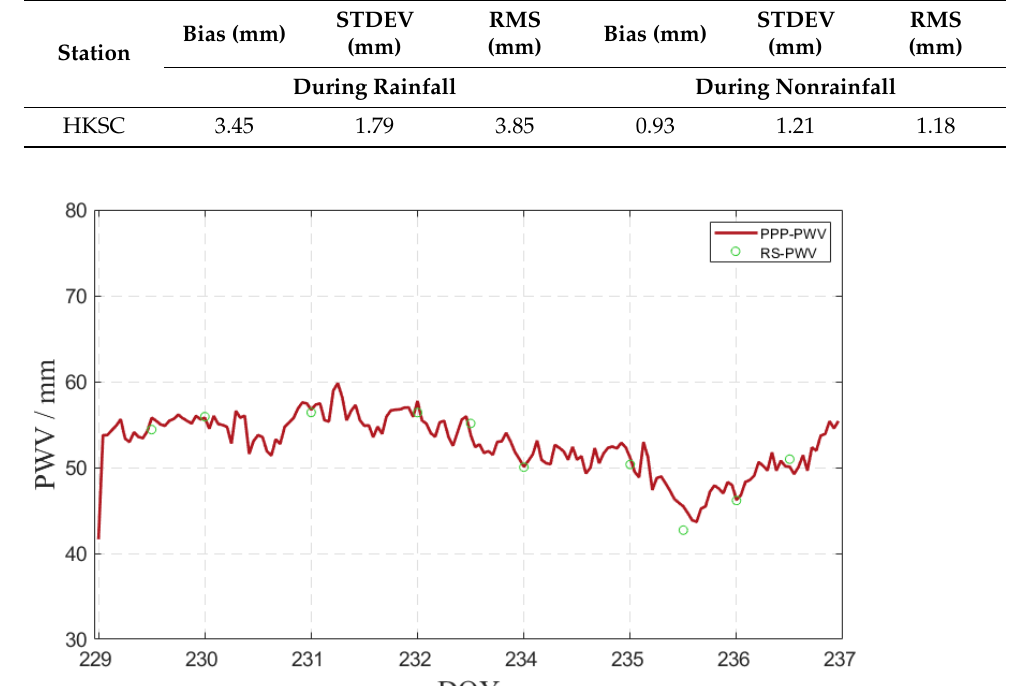
Figure 6. Comparison of PPP PWV between HKSC station and radiosonde station during rainfall. Table 7. Bias, STDEV, and RMS between PPP PWV and radiosonde station PWV. Station